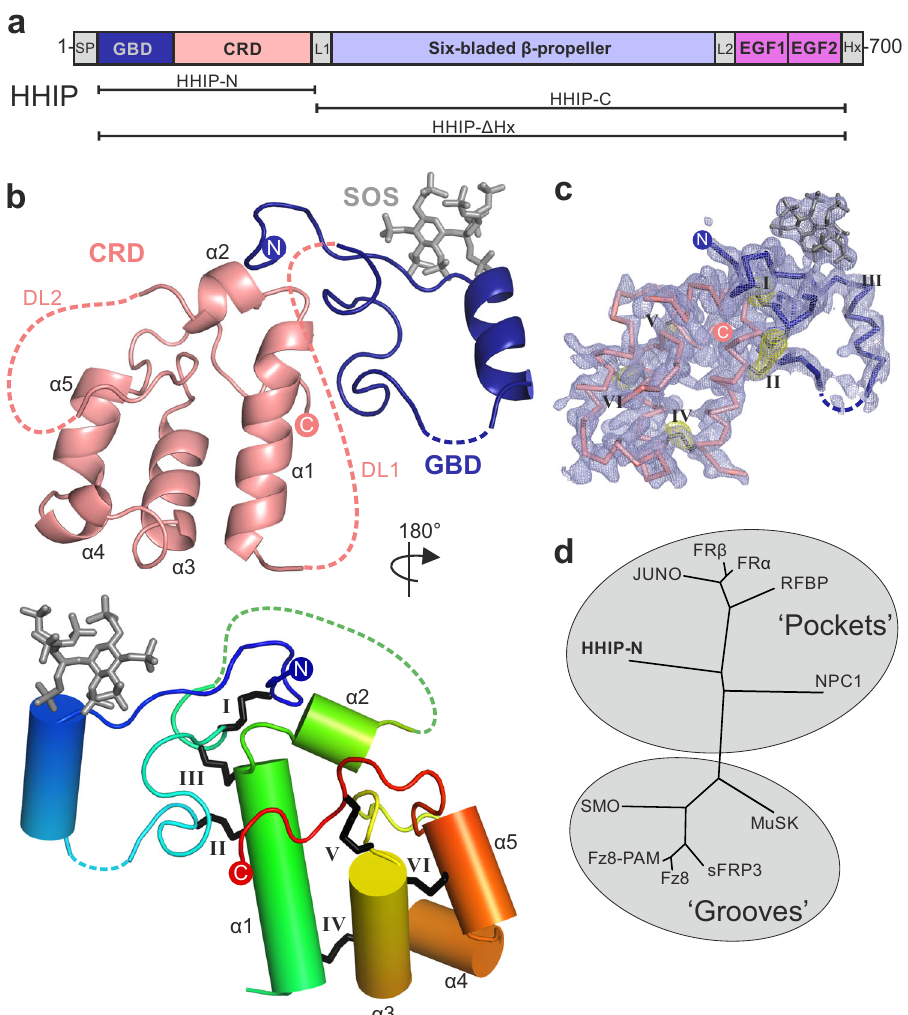
Fig. 1 The structure of HHIP-N. a HHIP domain organisation and construct design. b Cartoon representation of HHIP-N in complex with SOS. In the top panel, the CRD region is depicted in salmon and the N-terminal GAG-binding domain in dark blue. Two disordered loops (DL1 and DL2) are displayed as dashed salmon lines. In the lower panel, the HHIP-N:SOS complex is shown in rainbow colouring (blue: N-terminus, red: C-terminus). The CRD helices are labelled and disulphide bonds are numbered using Roman numerals. c Maps calculated from fi nal HHIP-N model. The 2Fo-Fc map is shown in blue, contoured at 1 σ . An anomalous difference map calculated from S-SAD data used for phasing is displayed as a yellow mesh contoured at 4 σ . Corresponding disulphide bonds are numbered using Roman numerals. d Structural phylogenetic analysis of CRDs (see Supplementary